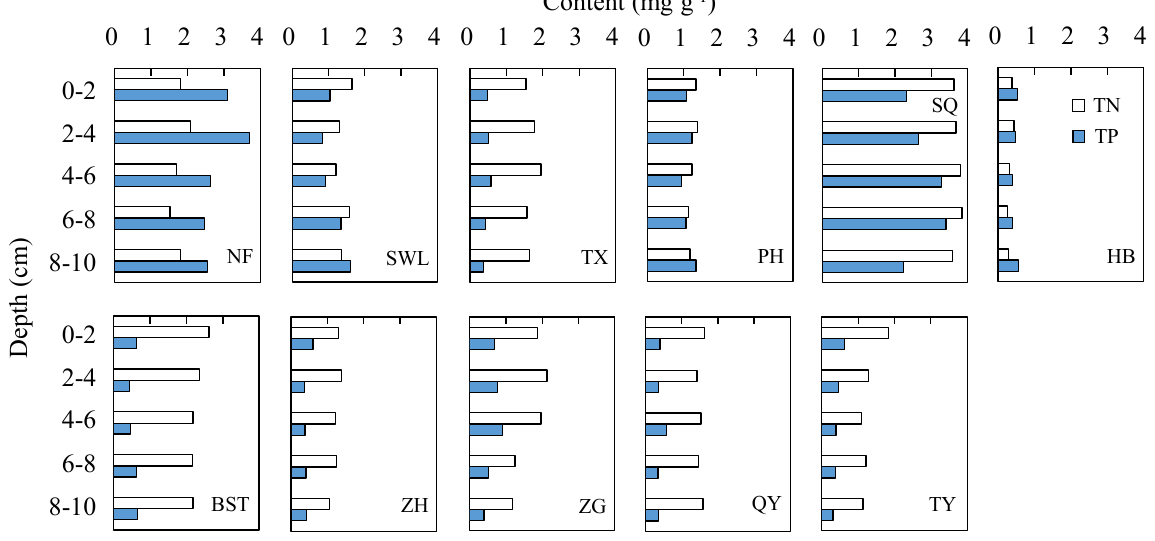
Figure 5. Distributions of TN (total nitrogen) and TP (total phosphorus) in sediment cores from 11 rivers flowing into Lake